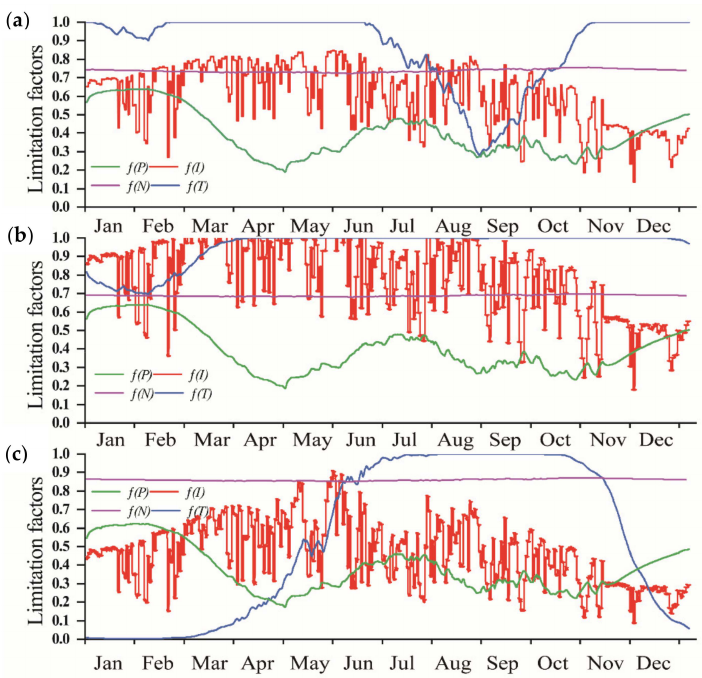
Figure 6. Time variation of phytoplankton communities and limitation factors of 3 algal groups in Lake Erhai; ( a ) Diatom; ( b ) Green Algae; ( c ) Cyanobacteria; ( T ), ƒ( I ), ƒ( N ) and ƒ( P ) represent water temperature, irradiation, nitrogen and phosphorus limitation, respectively.